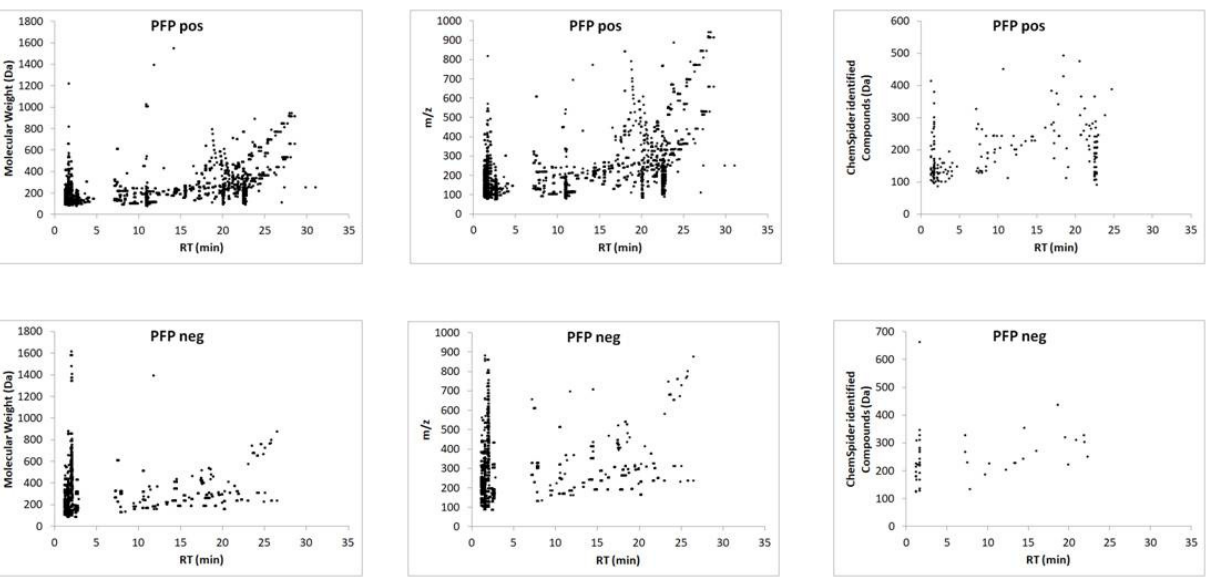
Figure 2. Ion map of extracted metabolites defined by molecular weight and m/z, and Chemspider- identified compounds from the PFP and HILIC column in positive and negative ionization mode followed by LC–MS analysis. 3.2. Metabolomic Changes in Tissue Samples of Gliomas Compared to Meningiomas The first step of the analysis aimed to determine whether the proposed strategy is able to distinguish between two tumors of completely different histological origin, as well as their degree of malignancy. For this purpose, gliomas and meningiomas (MEN) were chosen. In addition, the glioma group consisted of high- and low-grade-malignancy (HGG and LGG, respectively) tumors. As noted earlier, gliomas are highly malignant tumors that arise from glia cells; in contrast, meningiomas are benign tumors that form from me- ninges. Therefore, the separation between these groups needs to be significant, despite intra-group variability. This study employed two statistical methods of variable selection: one consisting of filter techniques that act on the intrinsic properties of the data itself,